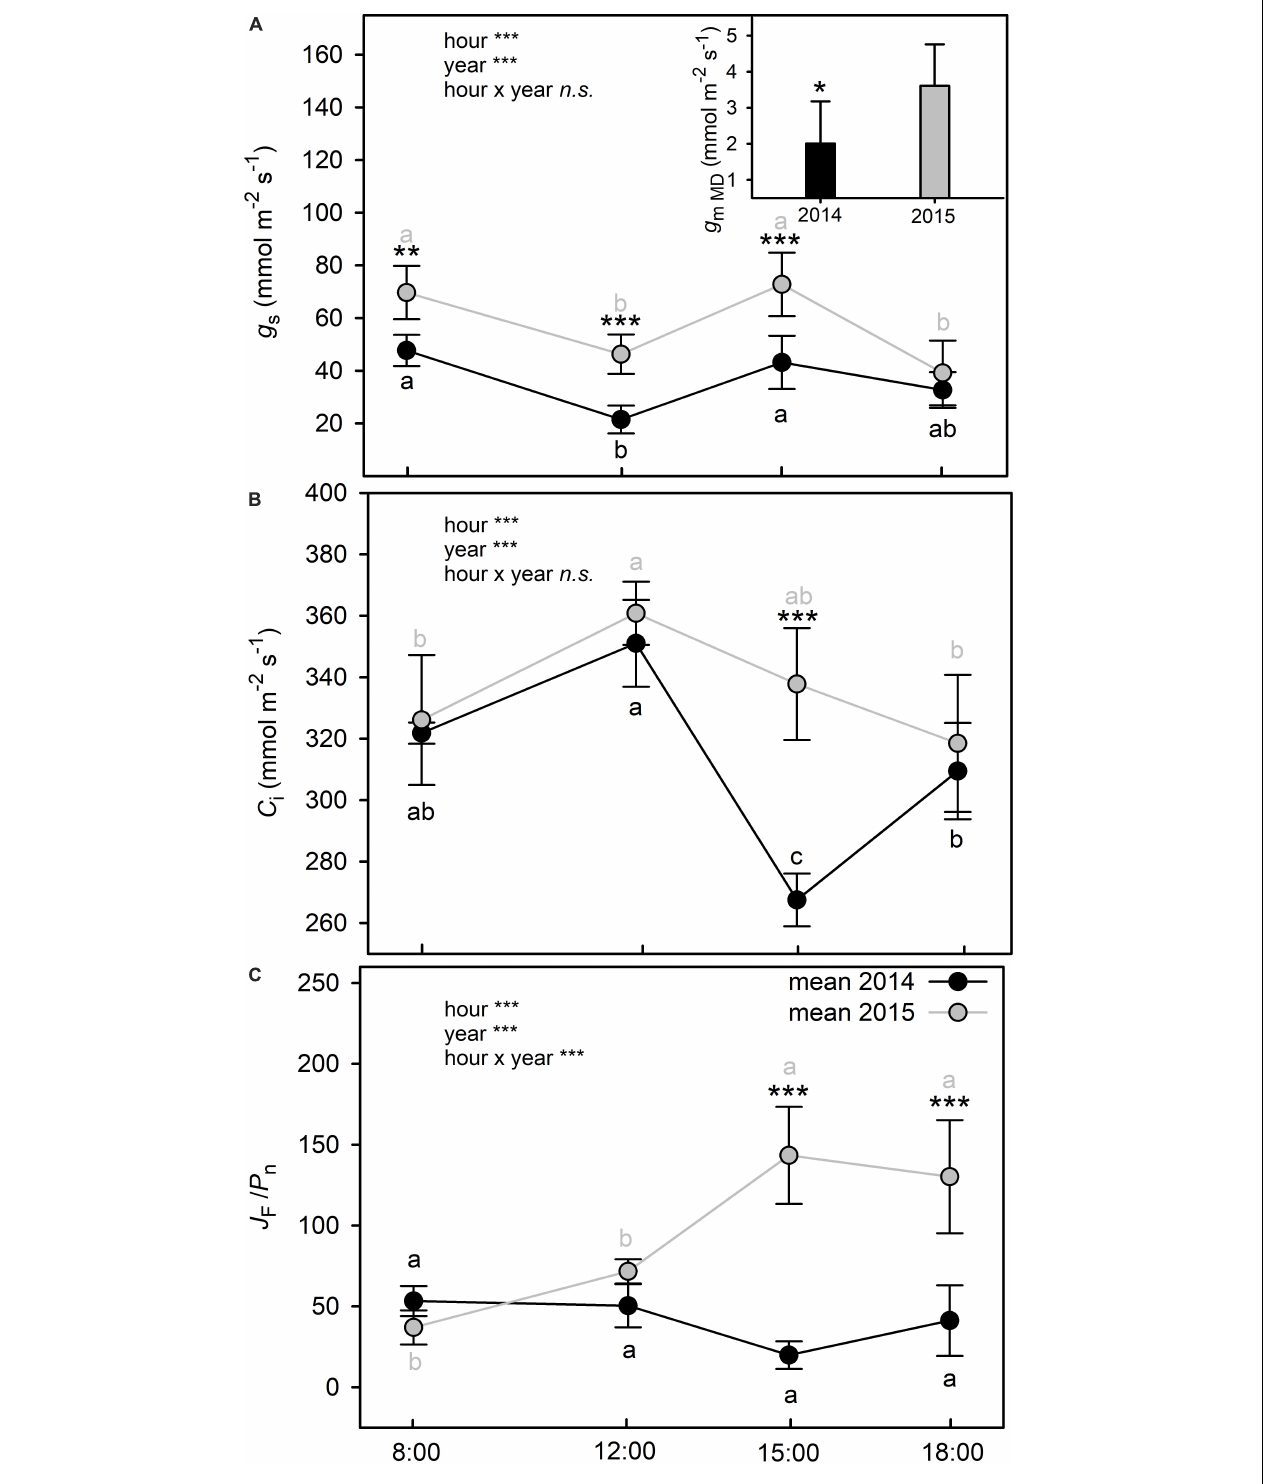
FIGURE 4 | Time course of stomatal conductance ( g s ) (A) , intercellular CO 2 concentration ( C i ) (B) , and electron transport rate ( J F ) to net photosynthetic rate ( P n ) ratio (C) of C. incanus leaves in July 2014 and 2015. Insert graph in (A) shows mesophyll conductance at midday ( g mMD ) in July 2014 and 2015. Two way ANOVA followed by Tukey’s pairwise comparison was performed to compare data (means ± SD; n = 8). Letters indicate significant differences ( p ≤ 0.05) among sampling hour for each year, whereas asterisks represent significant differences among years for each sampling hour, *( p ≤ 0.05), **( p ≤ 0.01), ***( p ≤ 0.001). The statistic adopted for the inclusion in (A) was a Student’s t -test, asterisks represent differences between the two years, *( p ≤ 0.05), **( p ≤ 0.01), ***( p ≤ 0.001).